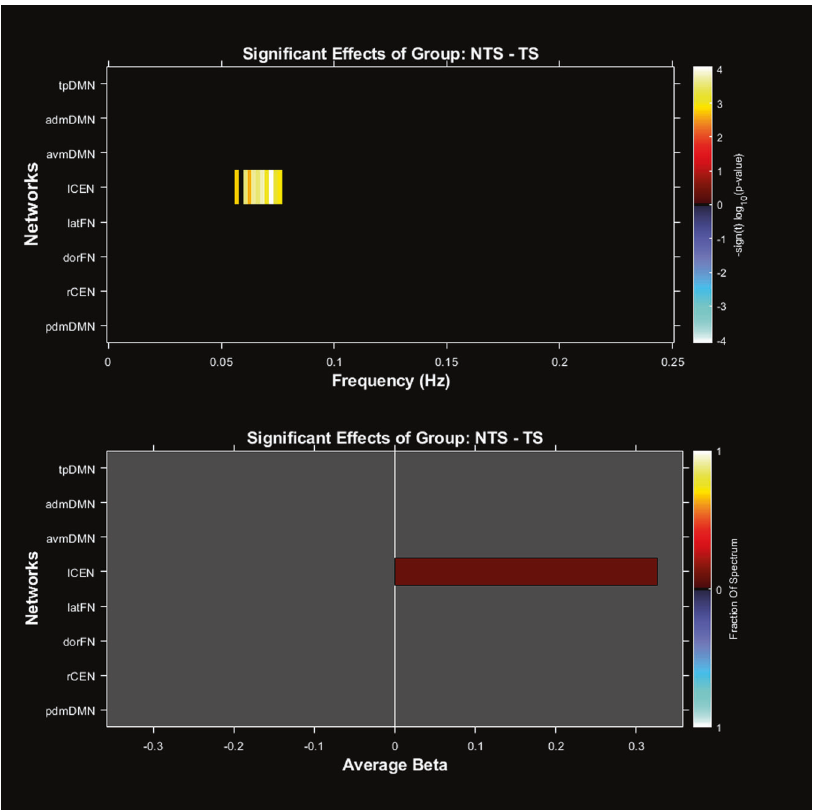
Fig. 2 Group differences in spectral power. Differences between torture survivor (TS) compared to non-torture survivor (NTS) groups in spectral power in the left central executive network (lCEN). Effect size is also